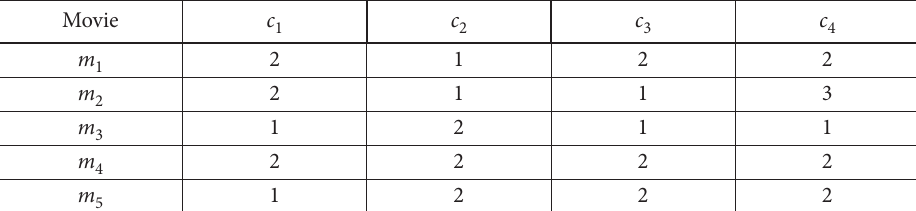
Table 5. Ranking alternatives based on variance